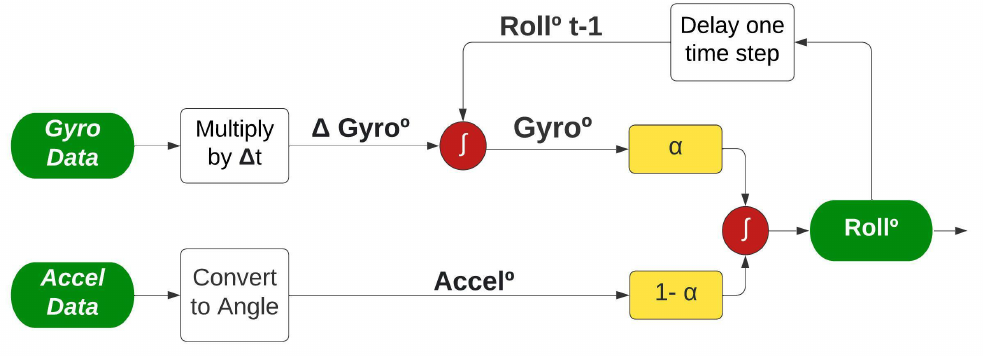
Figure 7. Complementary Filter applied to IMU sensor, adapted from [27].